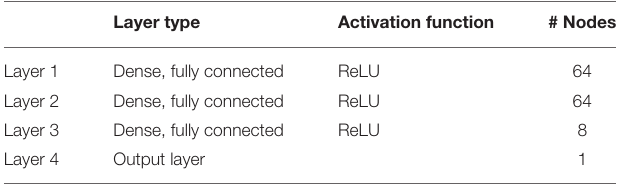
TABLE 2 | Description of the four layer model architecture used to predict dissolved oxygen and nutrient